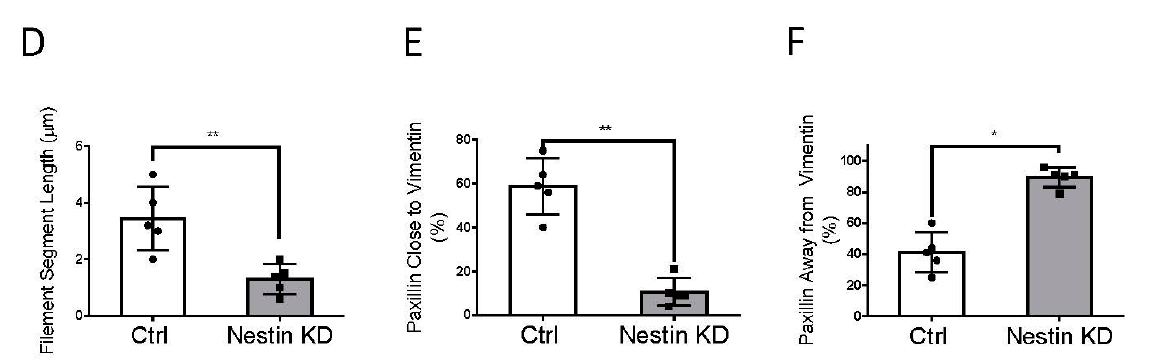
Figure 3. Nestin KD affects Plk1 phosphorylation at Thr-210, vimentin phosphorylation at Ser-56, and vimentin network. ( A ) Extracts of Ctrl and nestin KD cells were immunoblotted with antibodies against phospho-Plk1 (Thr-210) and total Plk1. Plk1 phosphorylation is normalized to the level obtained from Ctrl cells. Data are mean ± SE ( n = 4). ( B ) Extracts of Ctrl and nestin KD cells were immunoblotted with antibodies against phospho-vimentin (Ser-56) and total vimentin. Vimentin phosphorylation is normalized to the level obtained from Ctrl cells. Data are mean ± SE ( n = 4). ( C ) Ctrl and nestin KD ASM cells were plated on collagen-coated coverslips for 45 min and immunostained for vimentin and paxillin. Cell images were taken using a Zeiss LSM880 microscope with Airyscan. The images of vimentin filaments and paxillin staining in cell protrusions were used for Imaris quantitative analysis. Scale bar: 15 µ m. Imaris software was utilized to 3D-render vimentin filaments and paxillin surfaces. 3D-rendered vimentin is green, paxillin closed to vimentin is cyan, and paxillin alone is red. ( D ) The Imaris software was utilized to quantify the length of filament segments. ( E , F ) The percent of paxillin clusters closed to or away from vimentin filaments was assessed using the Imaris software. Data are mean ± SE ( n = 5). t -test was used for statistical analysis. * p < 0.05; ** p <